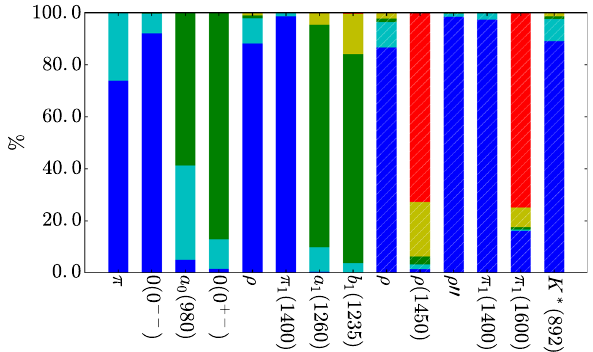
Fig. 11 Overview of OAMD for all states presented in Figs. 7 and 8. Bars without hatch correspond to the best-fit model parameter set used in Fig. 7, while hatched bars correspond to the secondary parameter set used in Fig. 8. Colors like in Fig. 7